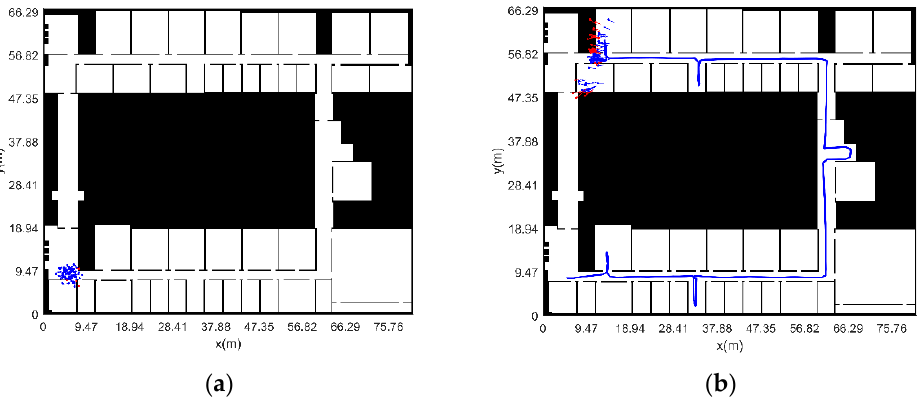
Figure 15. Sampling particle distribution and motion trace under the condition of known initial position and heading. ( a ) Particle distribution at the initial moment. ( b ) Particle distribution and trace during motion.